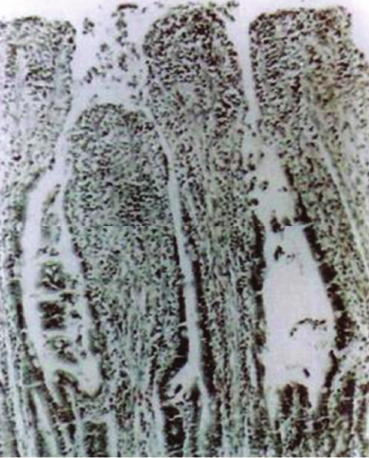
Figure 13: Section of intestine of the same dog showing necrotic enteritis and exfoliation of cells (H. E. original magnification ×